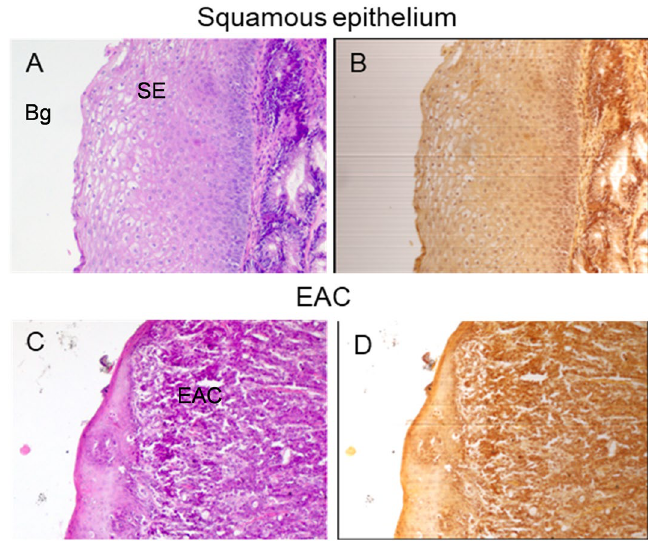
Figure 1. Hematoxylin and eosin (HE) stained specimens. Specimens were stained for HSI imaging standardizedly. Areas with squamous epithelium ( A ) or EAC cells ( C ) were selected and recorded by the HSI camera. The corresponding RGB images reconstructed from the HSI data are shown in ( B ) and ( D ) ( Bg Background, SE Squamous epithelium and EAC Esophageal adenocarcinoma